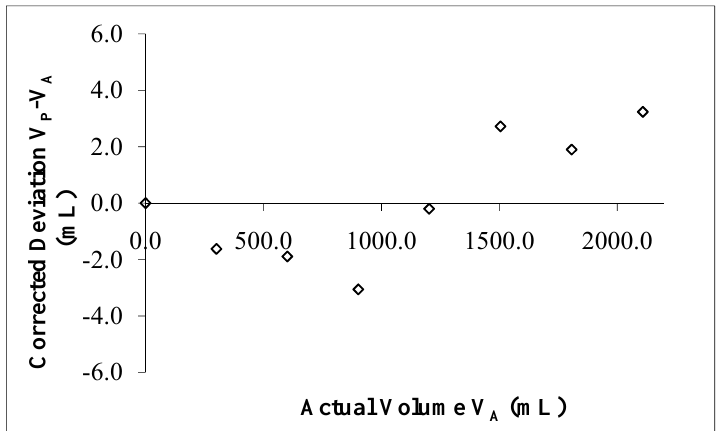
Figure 5. Actual water volume versus corrected deviation volume ( V Helmholtz equation with second order correction. Measured using 3 L chamber, 170 mm long, and 44 mm diameter port.